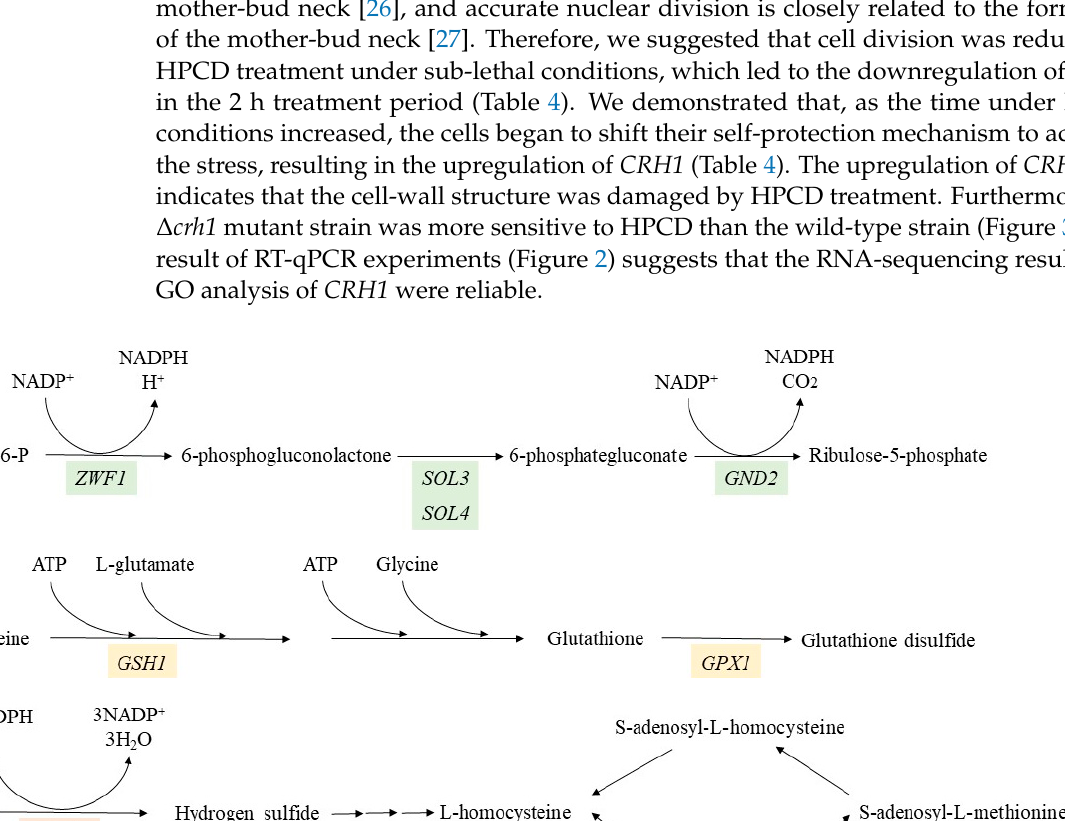
Figure 4. The sensitivity of normal cells and protoplast cells to HPCD treatment. ( a ) Survival of yeast cell rates after HPCD treatment. The percentage before treatment was set to 100%. ( b ) Visualization of yeast cells by phase-contrast microscopy.